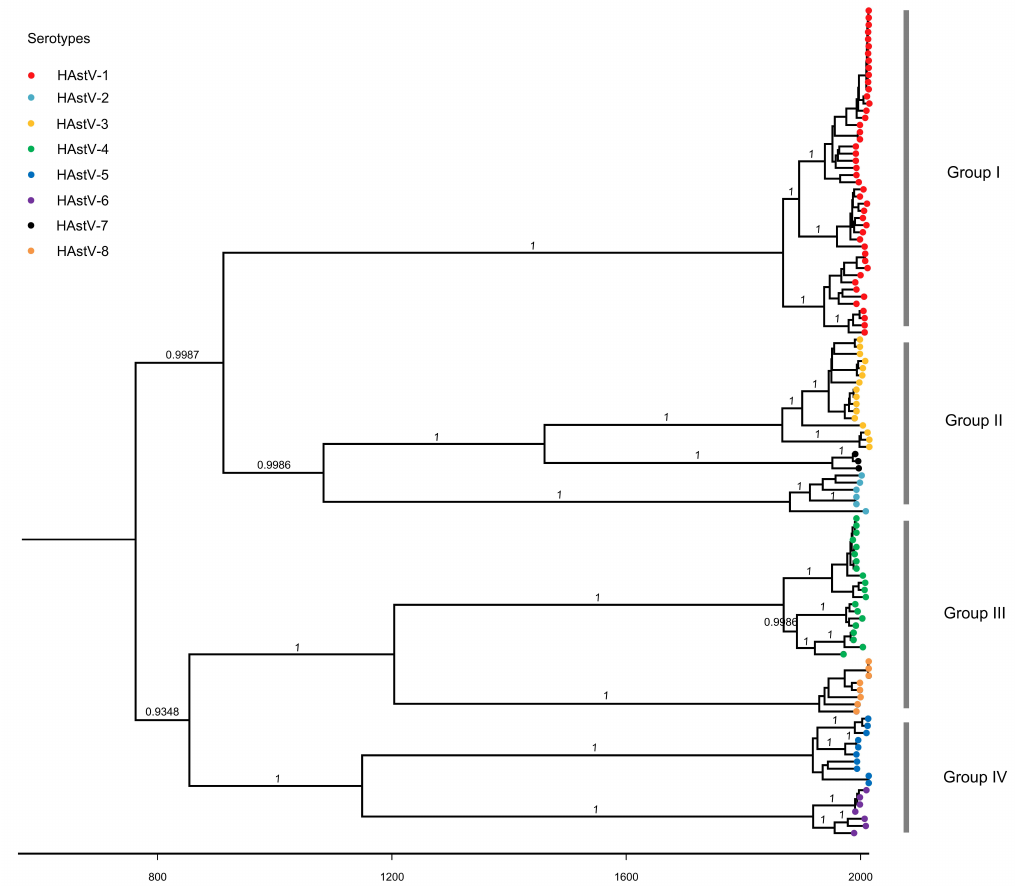
Figure 3. Phylogenetic tree of the capsid protein gene of classic HAstVs constructed by the Bayesian Markov Chain Monte Carlo method. Branches are scaled in time and sequences are colored by serotypes. Posterior probability support is indicated by the number along the